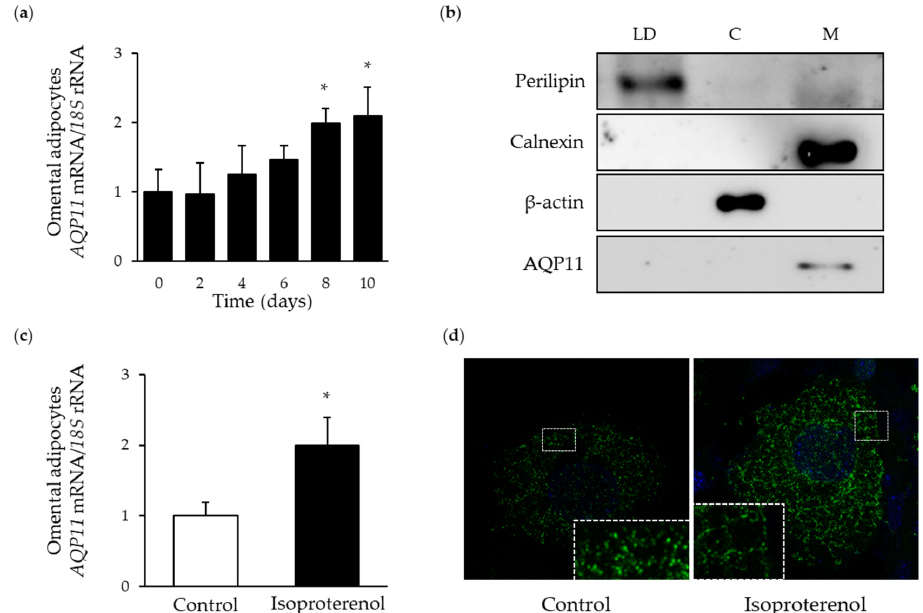
Figure 2. Characterization of AQP11 during adipocyte differentiation and lipolysis. ( a ) Time course of AQP11 mRNA expression during adipocyte differentiation. ( b ) AQP11 protein expression in differentiated adipocyte fractions corresponding to lipid droplets (LD), cytosol (C) or membranes (M); perilipin, β -actin, and calnexin were used as markers for lipid droplets, cytoplasm, or endoplasmic reticulum membrane, respectively. AQP11 mRNA expression ( c ) and protein redistribution ( d ) after 24 h treatment with isoproterenol (10 µmol/L) in human differentiated adipocytes. Gene expression in SVFC in day 0 or control adipocytes were assumed to be 1. * p < 0.05 vs mRNA expression in omental WAT; * p < 0.05 vs mRNA expression in SVFC in day 0 or control adipocytes.